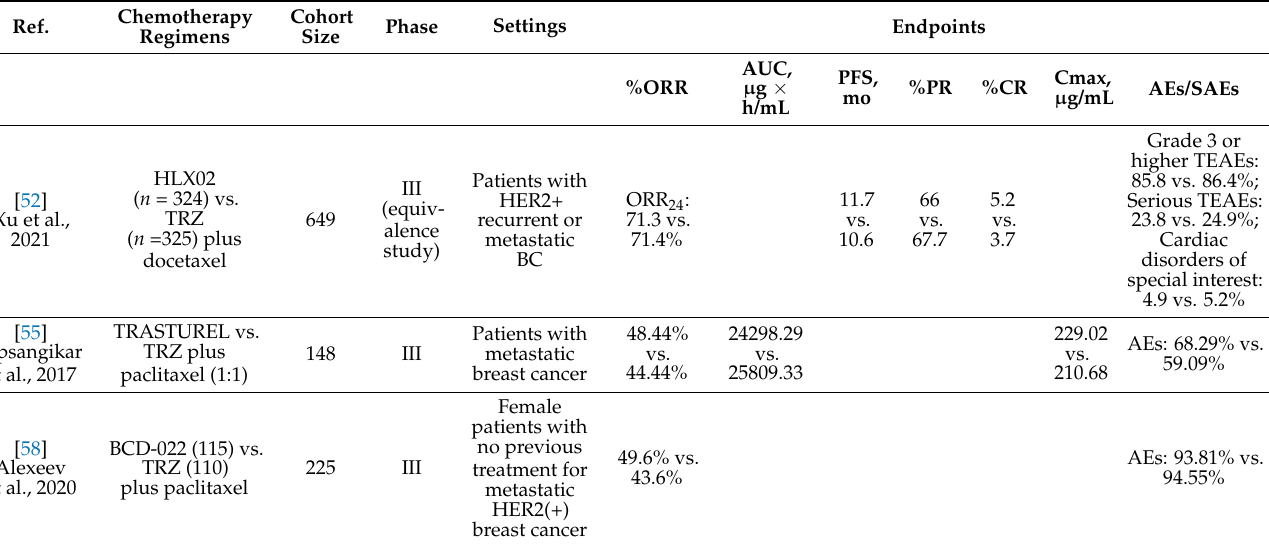
Table 6. Summary of phase III clinical trials evaluating the safety, efficacy, and pharmacokinetics of trastuzumab biosimilars under investigation in patients with HER2+ breast